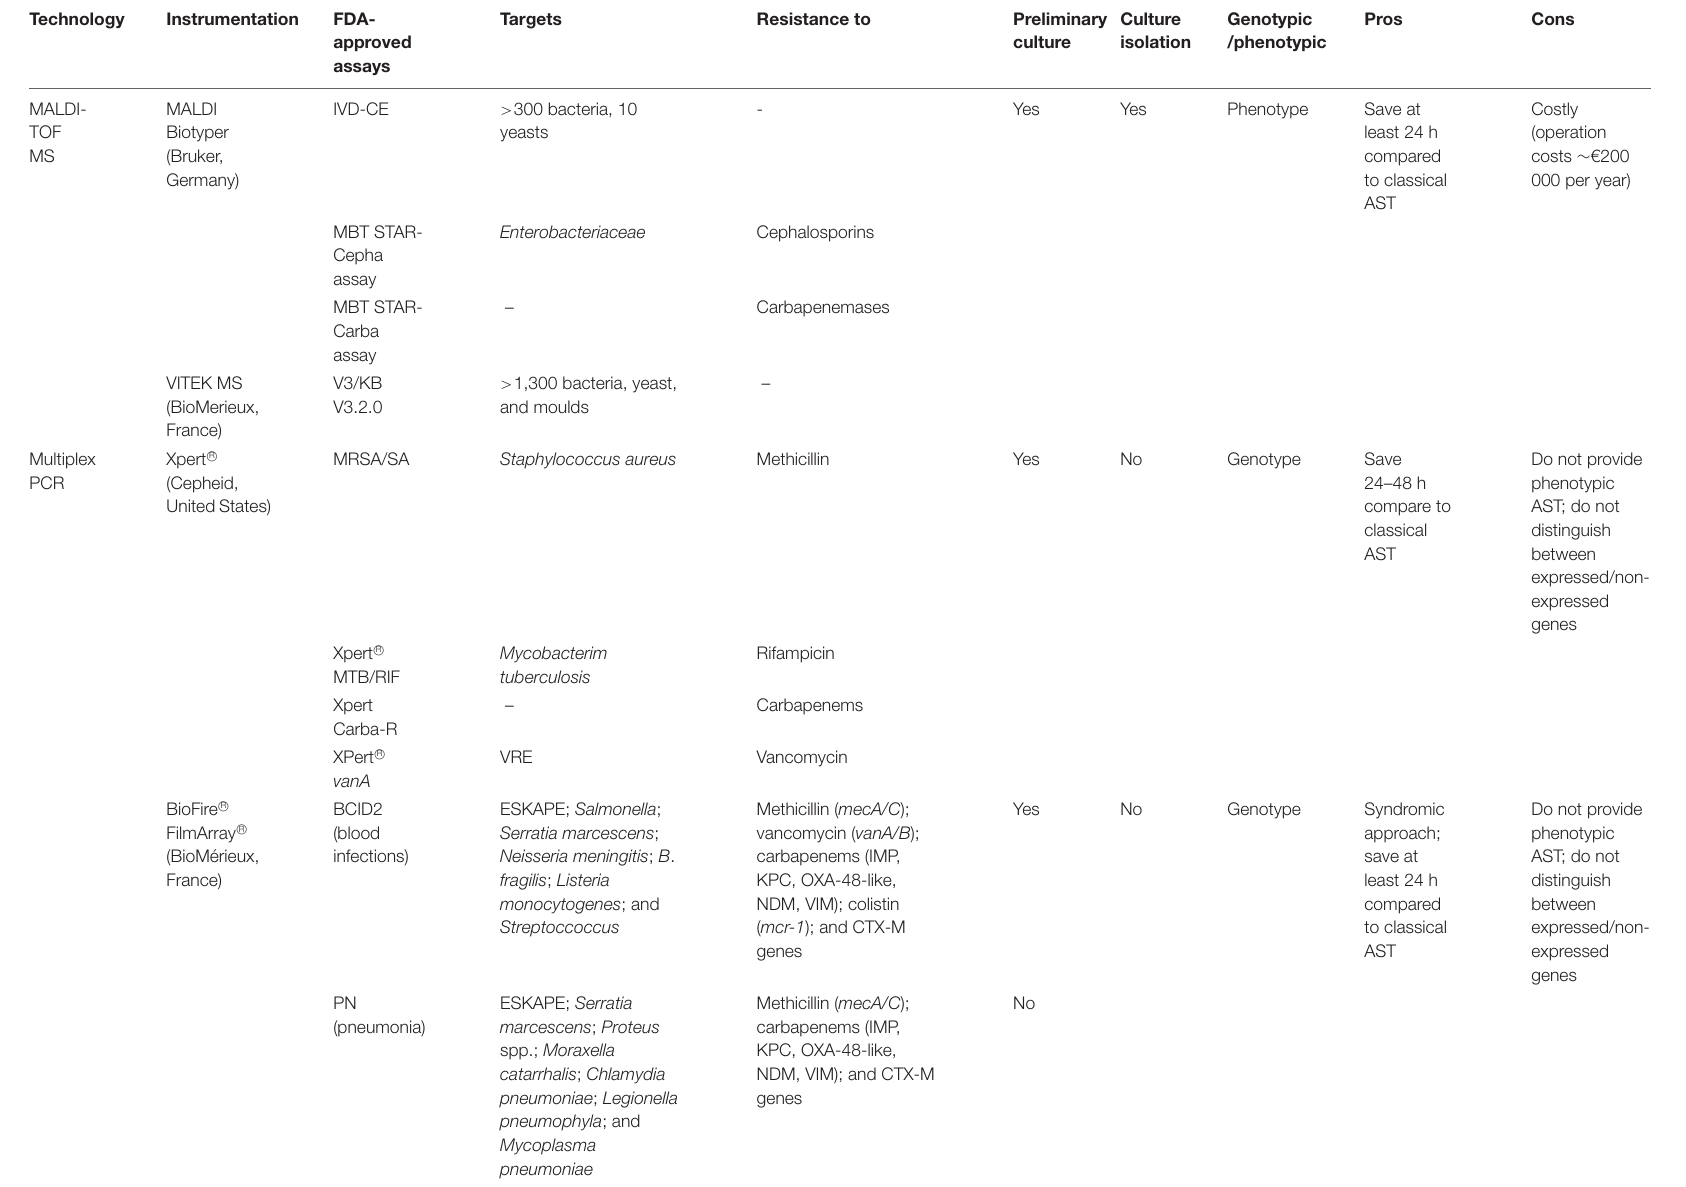
TABLE 1 | Overview of alternatives to classical antibiotic susceptibility testing (AST) discussed in this review.